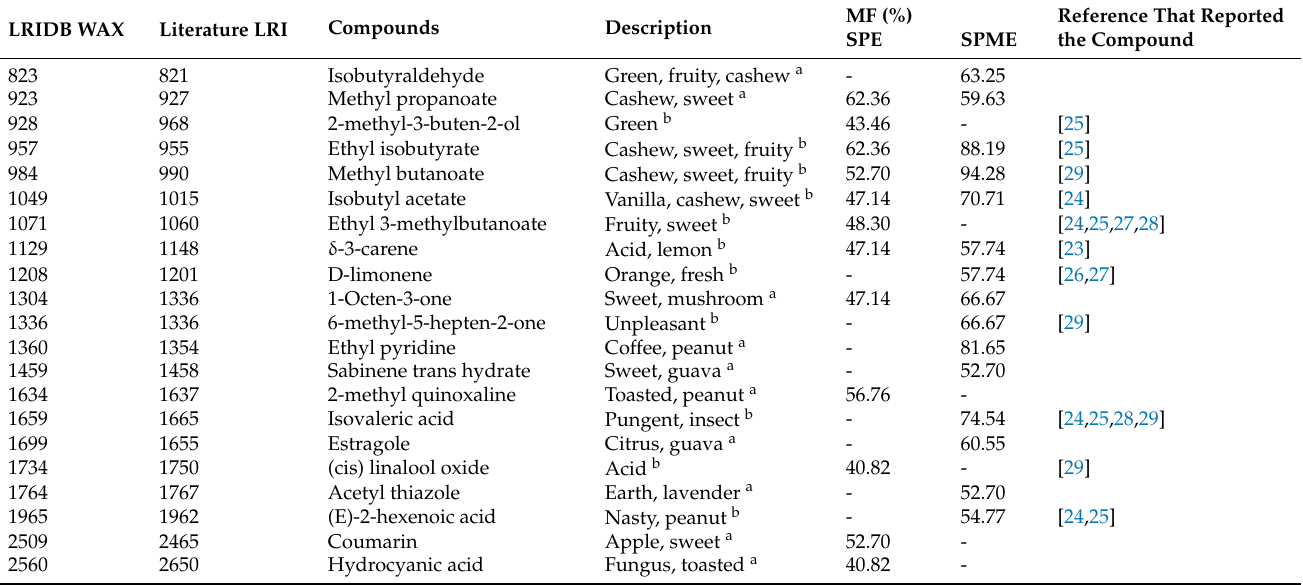
Table 2. Gas chromatography retention data, olfactometry description, chemical identification, and modified frequency (MF) (%) for odorants identified in “Cerrado” cashew obtained using headspace solid-phase extraction (HS-SPE) and headspace solid-phase microextraction (HS-SPME) with gas chromatography-olfactometry